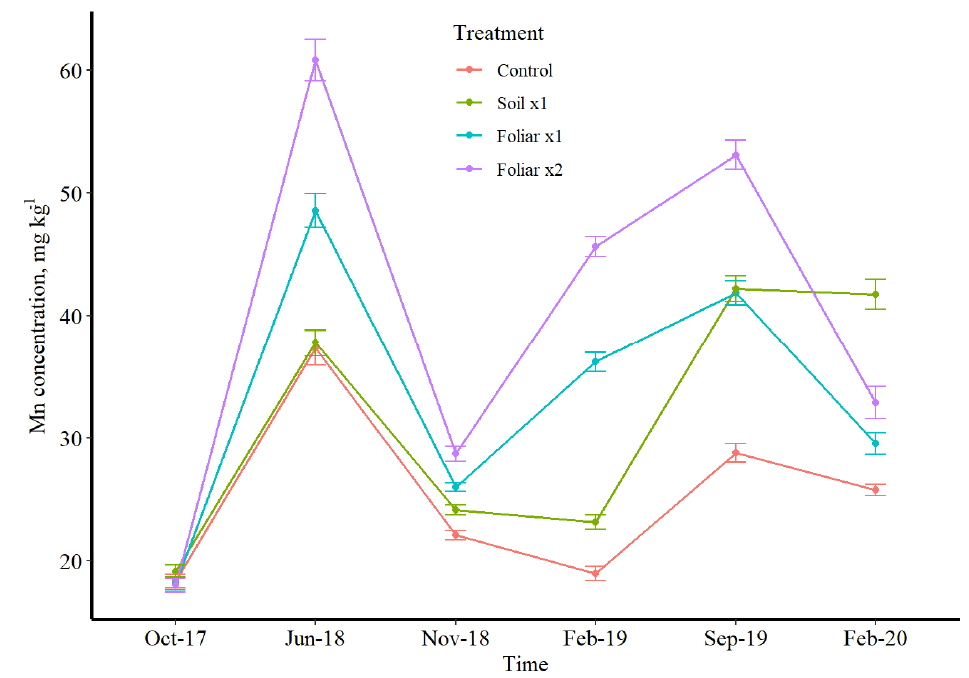
Figure 2. Mn leaf concentration over time in different micronutrient treatments (control, soil ×1. foliar ×1, and foliar ×2). B, Mn, and Zn rates were 1.12, 10.08, and 5.60 kg ha − 1 . Lines represent data with 95% confidence intervals.